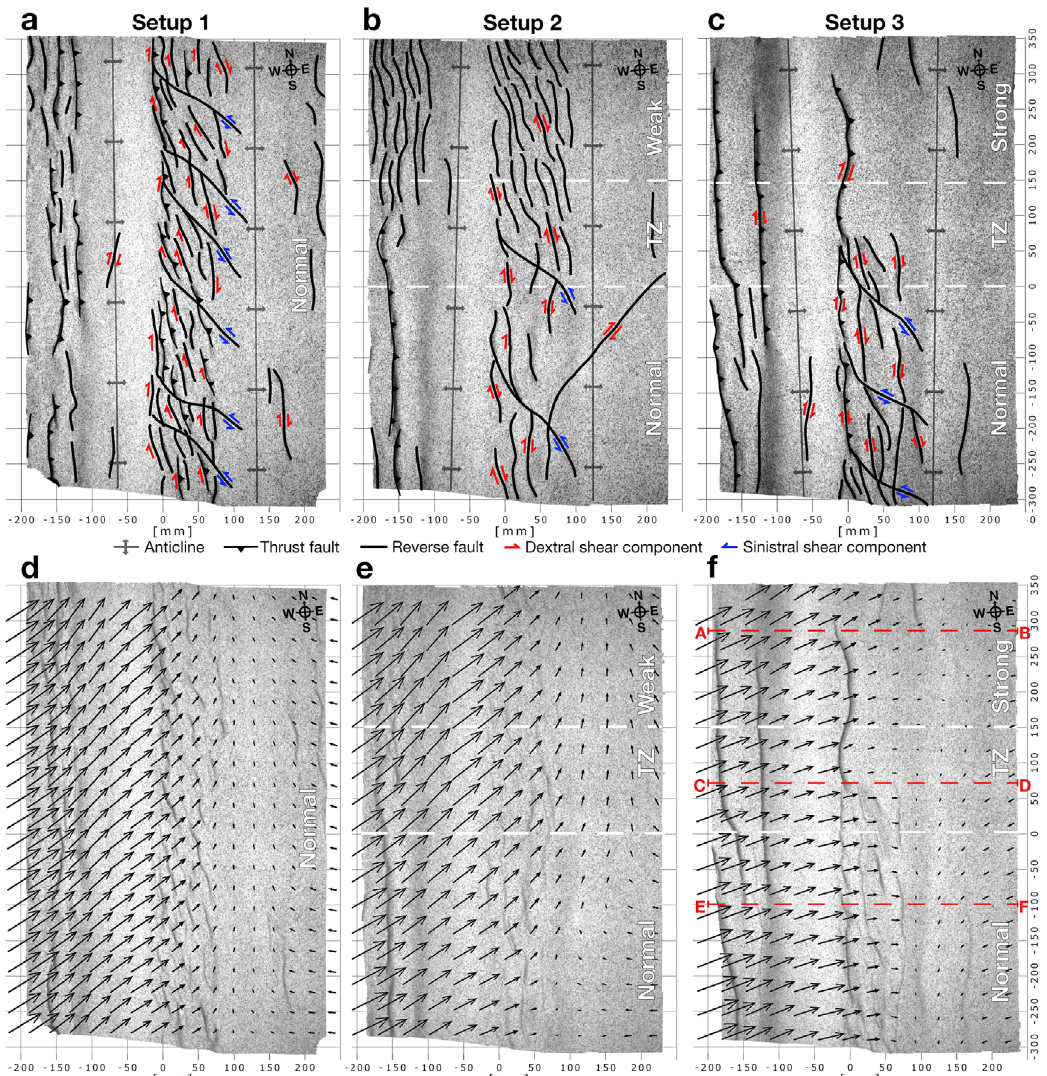
Fig. 4 Line drawings of model faults and cumulative model displacement vectors superposed on fi nal model surfaces. Model structures of a setup 1 experiments, b setup 2 experiments, and c setup 3 experiments. Model displacement vectors of d setup 1 experiments, e setup 2 experiments, and f setup 3 experiments. Red stippled lines indicate surface traces of pro fi les in Supplementary Fig. 5. TZ indicates the transition